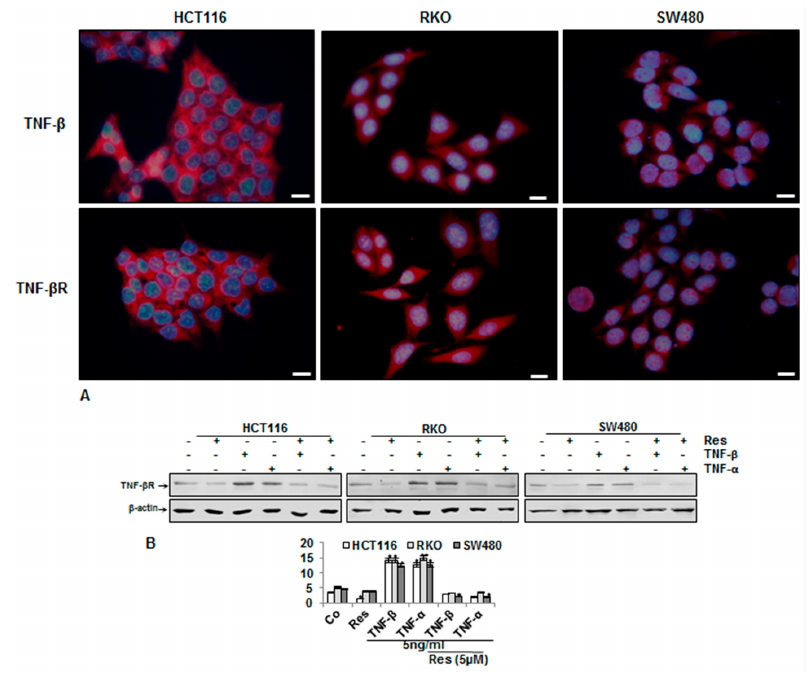
Figure 4. Expression of TNF- β receptor in three CRC cell lines and resveratrol suppressing their expression. ( A ) CRC cells in monolayer cultures were immunolabeled with primary antibodies for TNF- β and TNF- β receptor (TNF- β R), followed by incubation with rhodamine-coupled secondary antibodies and counterstaining with DAPI to visualize cell nuclei. Original magnification, 400x. Scale bar = 30 nm. ( B ) CRC cell lines in monolayer cultures were untreated (Co) or treated, as described above. Whole cell lysates were fractionated and immunoblotted with antibodies against TNF- β R and β -actin. β -actin was used as a loading control in all